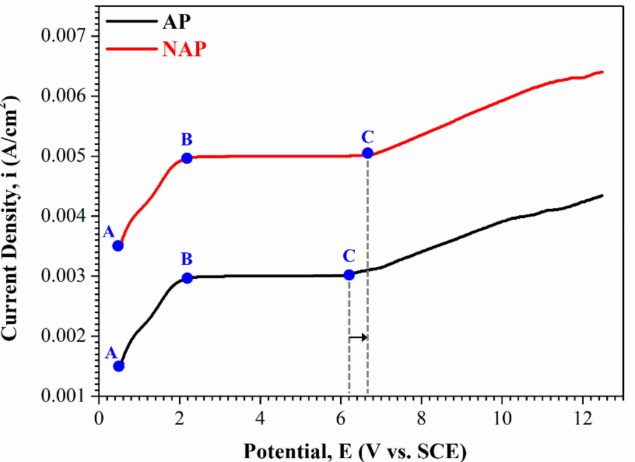
Figure 4. The potentiodynamic polarization curve of the NAP and AP samples electropolishing in the electropolishing